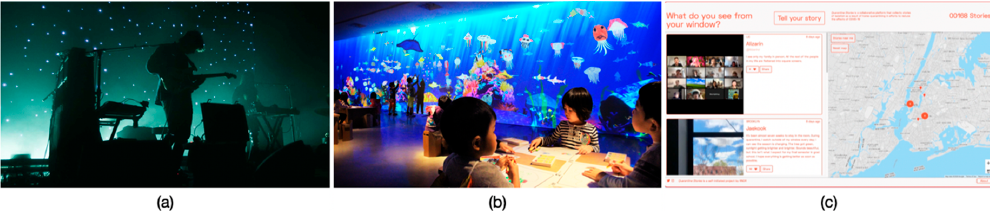
Figure 9. Examples suggested by the participants (Reprinted with permission): ( a ) Beach House concert, ( b ) TeamLab aquarium, and ( c ) Quarantine Stories by RNDR.